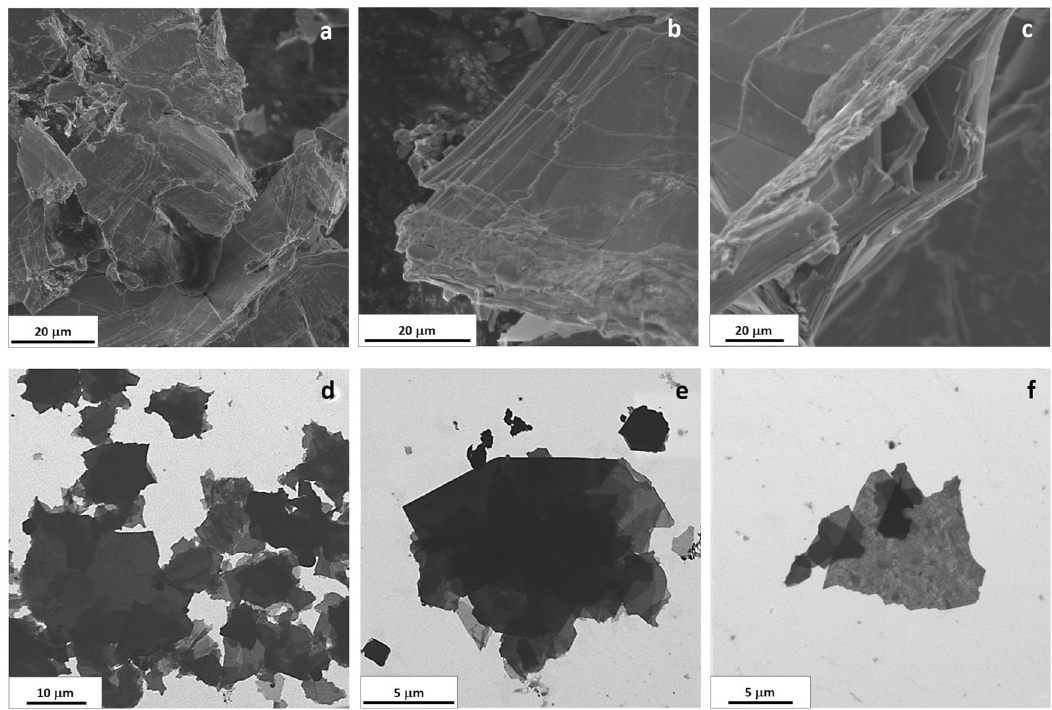
Fig. 1 Morphological characterization. SEM images ( a – c ) of bulk TaS 2 and STEM images ( d – f ) of exfoliated 2D TaS 2